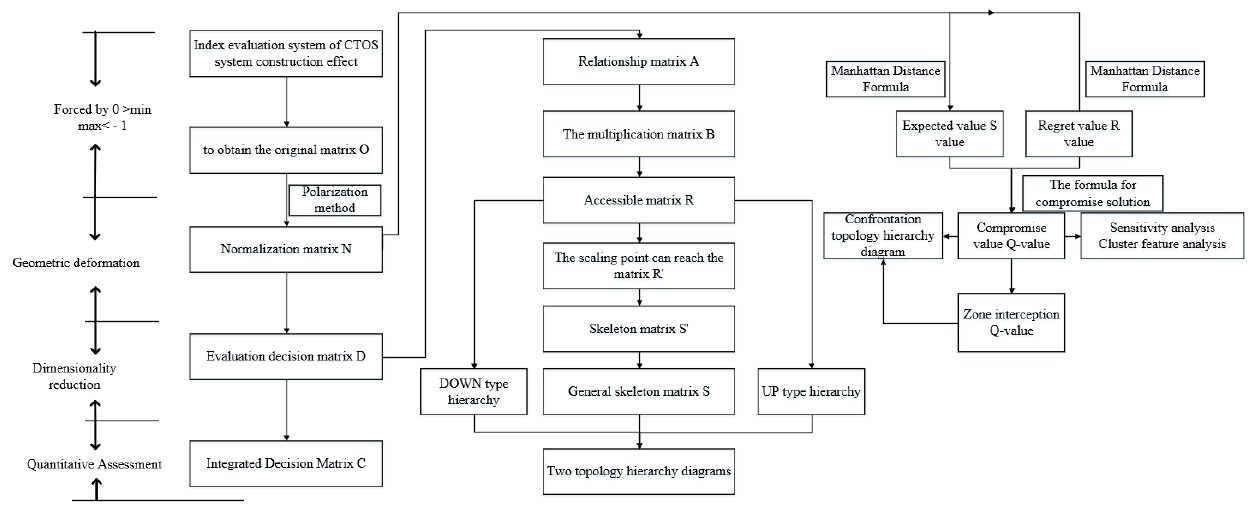
Figure 3. AISM flow chart.